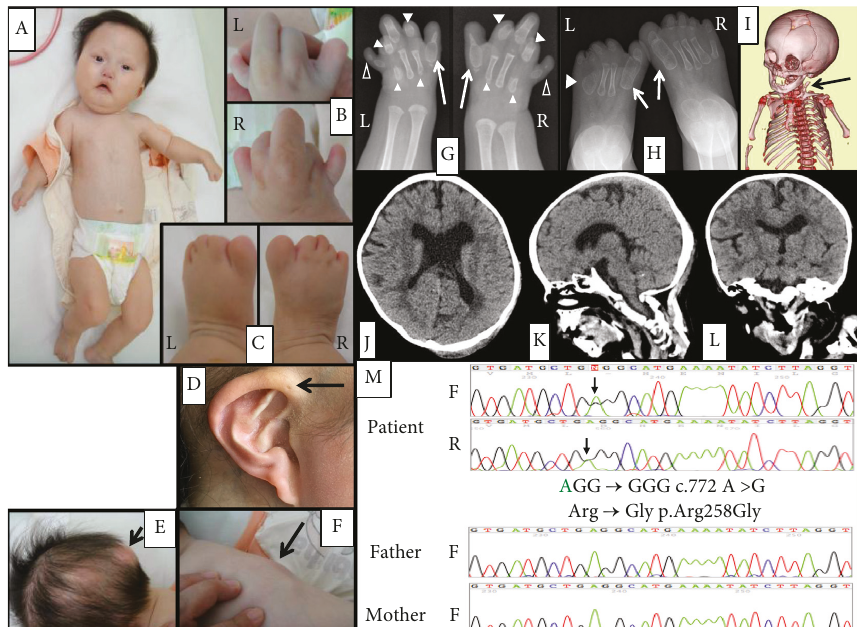
Figure 1: Clinical features, radiological examination findings, and genetic analysis results of our patient. (a–f) Clinical features of our patient at the first visit to our hospital. Left (L); right (R). (a) General appearance. Thin eyebrows, low-set ears, hypoplastic mandible, narrow chest, and shallow umbilicus were observed. (b) Hands. Incomplete syndactyly was observed in both hands. All fingers lacked nails. (c) Feet. Incomplete syndactyly was observed in both feet. All toes lacked nails. (d) Right ear. The lower part of the ear was hypoplastic. A periauricular sinus (arrow) was observed. (e) Flare-up observed at the occipital region of her head (arrow). The hair was sparse. (f) Flare-up observed at her back (arrow). (g–l) Results of radiological examinations. Left (L); right (R). (g) Roentgenograph of the hands at 7 months of age. Agenesis of all distal phalanges, second and fourth middle phalanges, and fifth metacarpal bone, fusion of enlarged first middle metacarpal bone and proximal phalange (arrows), shortened second and fourth metacarpal bones, and proximal phalanges (closed